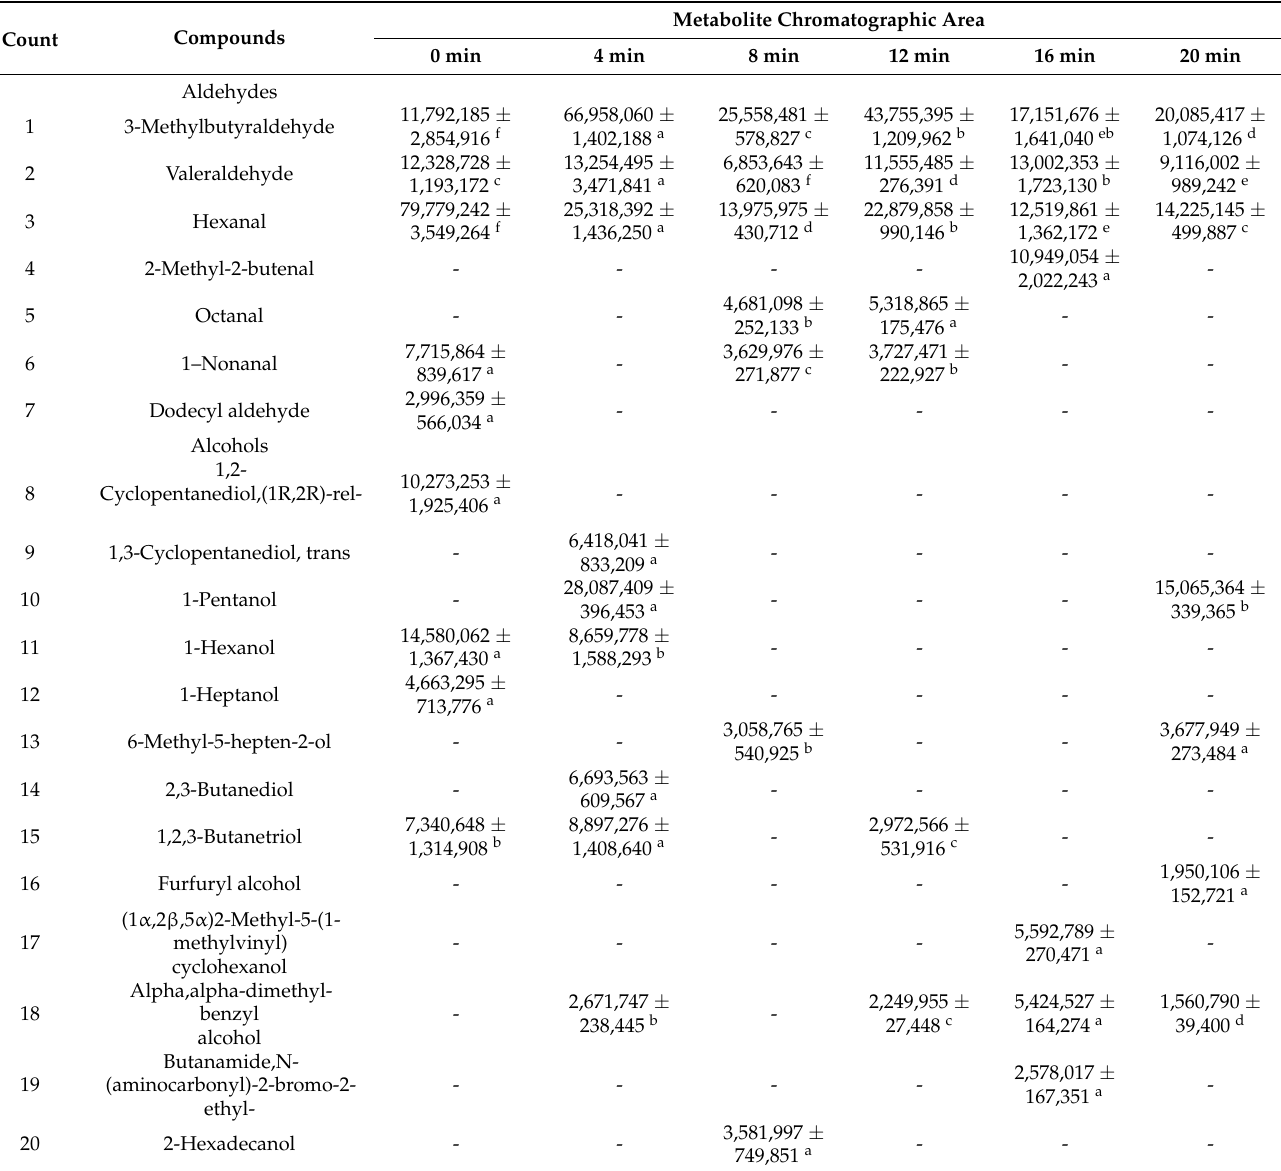
Table A3. Metabolite chromatographic area of defatted tiger nut